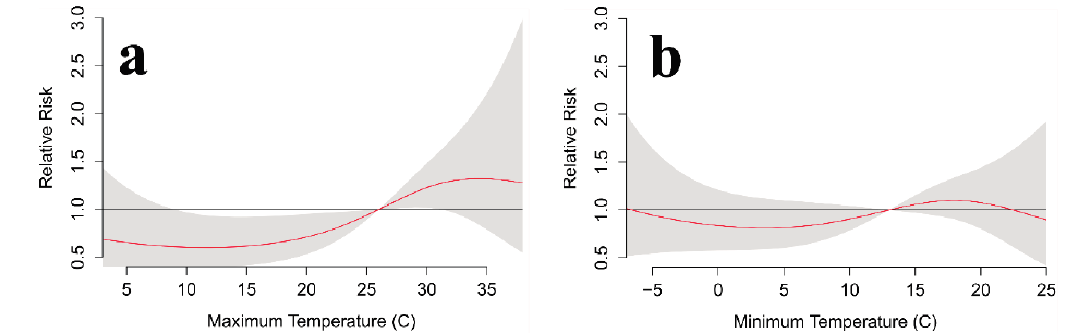
Figure 12. Jackson, MS annual relative risk for suicide at various daily ( a ) maximum and ( b ) minimum temperatures over a 6-day lag. The red line is the predicted value and the gray shading represents the 95% confidence